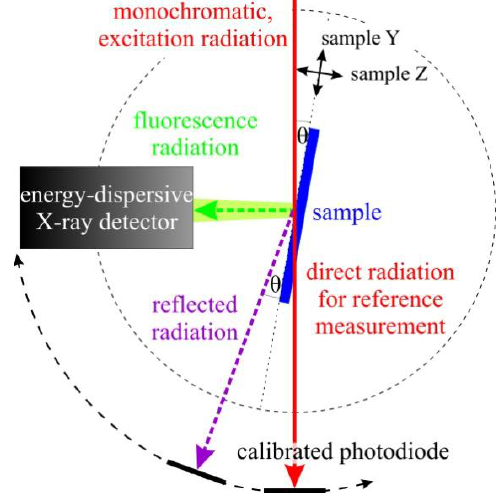
Figure 1. Sketch of the experimental GIXRF set-up in the UHV